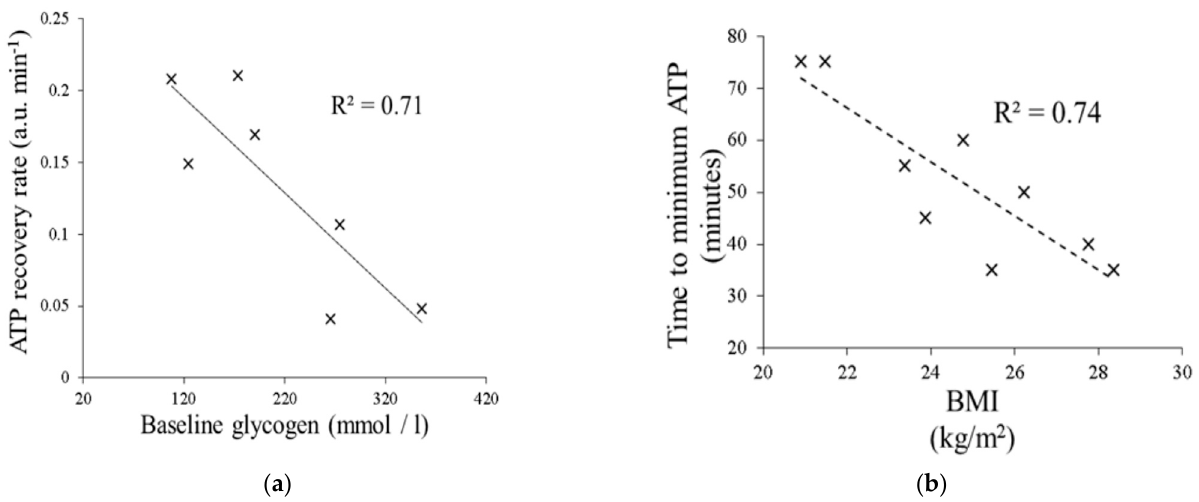
Figure 8. ( a ) Time to ATP recovery is inversely proportional to hepatic glycogen content. ( b ) Increasing BMI is associated with a shorter time to hepatic ATP depletion.